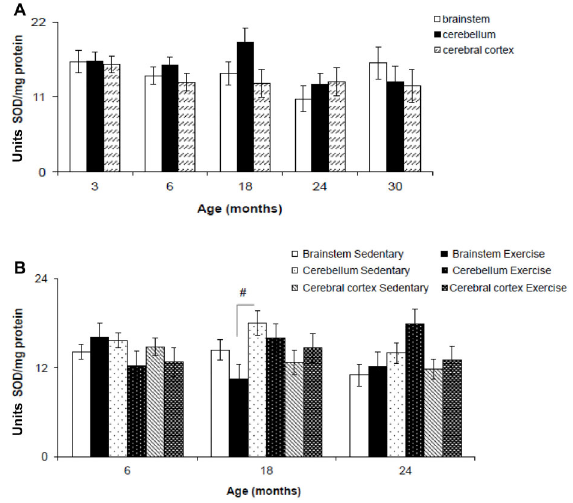
Figure 3. Superoxide dismutase activity (SOD) in the brainstem, cerebellum, and cerebral cortex of Wistar rats of different ages ( A ) and after 12 weeks of treadmill running ( B ). Data are reported as means ± SE. # P o 0.05, three-way ANOVA.